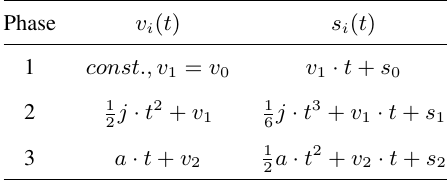
Table 1: Velocity and distance traveled of the ego vehicle at t ; i ∈ 1 . . . 3 , representing the phases. The use of index i − 1 in the determination for phase i refers to the last sample of phase i − 1